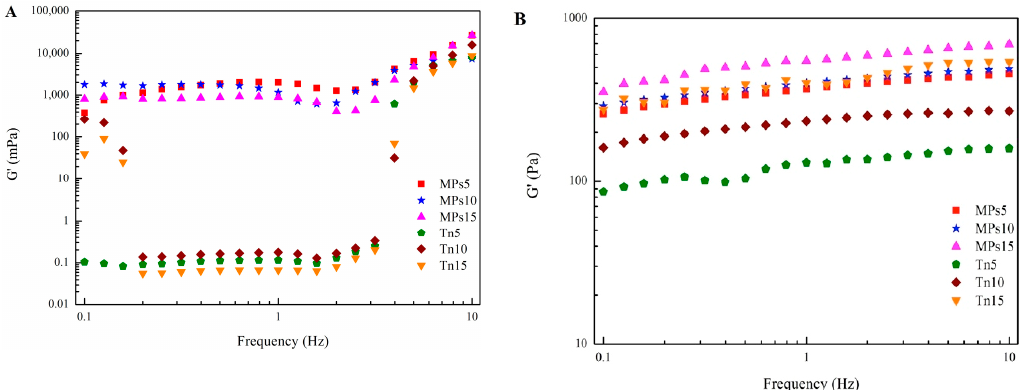
Figure 5. Storage modulus (G (cid:48) ) of MP- or Tween 80-stabilized camellia seed oil emulsions ( A ) and composite gels ( B ) across di ff erent frequencies at 25 ◦ C. MPs5, MPs10, and MPs15 = gels with MP-stabilized emulsions homogenized at 5000, 10,000, and 15,000 rpm, respectively; Tn5, Tn10, and Tn15 = gels with Tween 80-stabilized emulsions homogenized at 5000, 10,000, and 15,000 rpm,